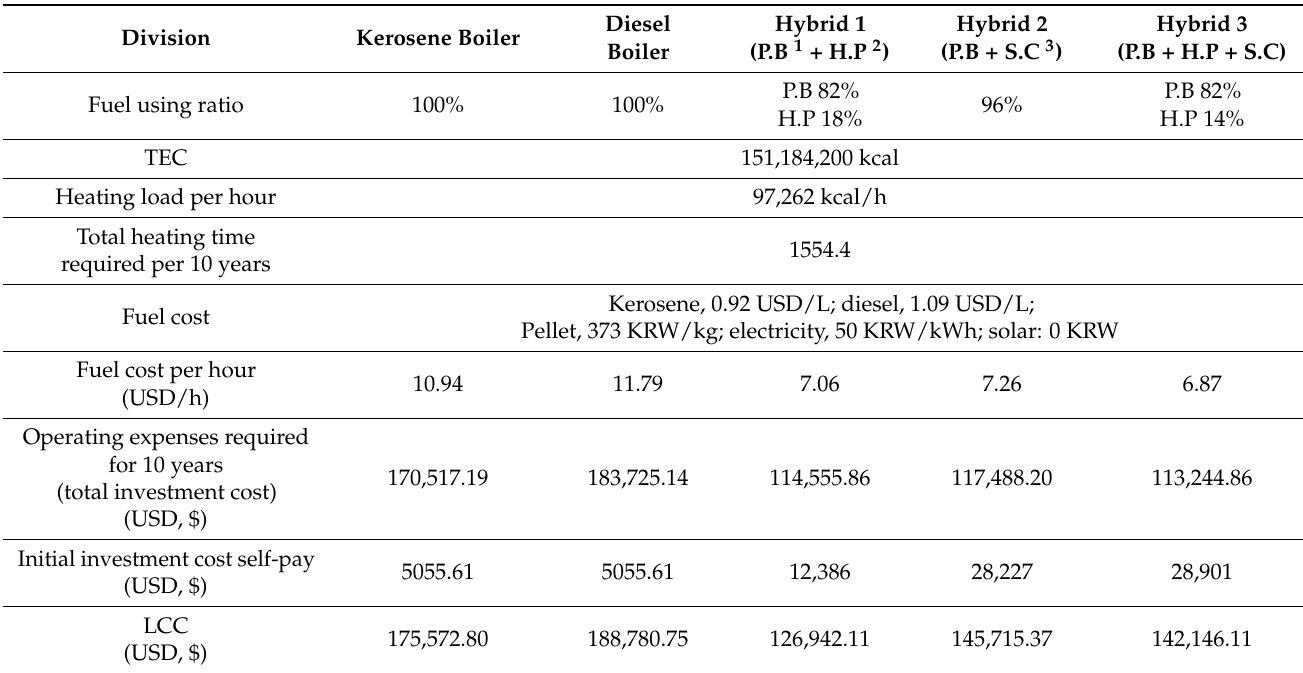
Table 11. Comparative results of economic analysis based on life cycle cost analysis for each